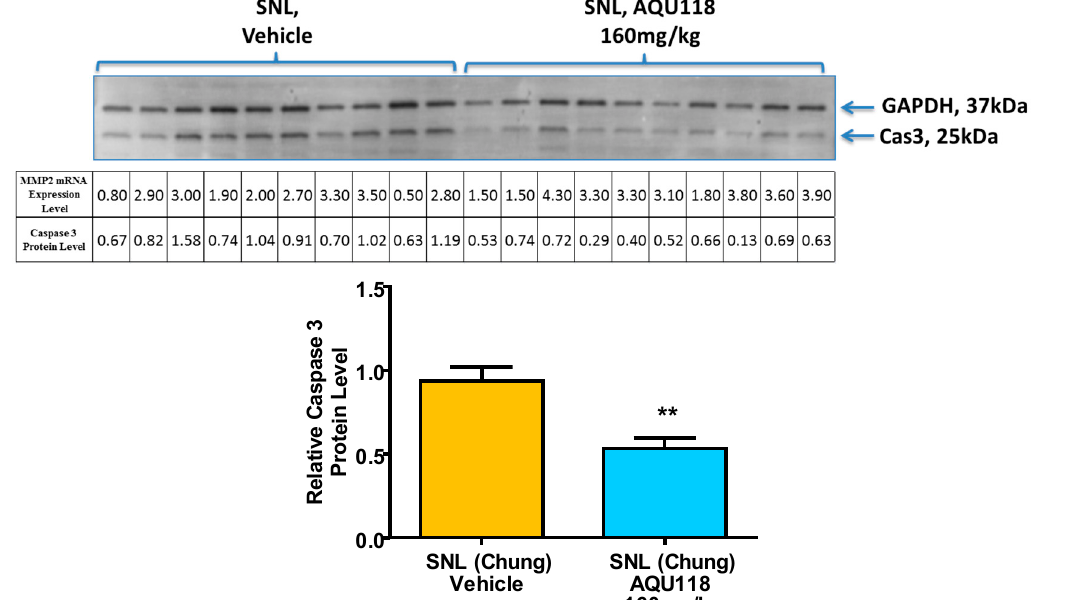
Figure 9. Comparison of MMP2 mRNA expression levels versus caspase-3 in a subset of ipsilateral DRG tissue for both vehicle and AQU-118 groups. Caspase 3 protein and MMP-2 mRNA expression levels were performed in the ipsilateral DRG tissue (via western blot) for both the AQU-118 ( n = 10) and vehicle ( n = 10) groups and compared to each other. The protein level is presented normalized to GAPDH and relative to the vehicle group (no samples were excluded in analysis). Data presented as the average ± SEM. An unpaired t-test was performed: **, p <